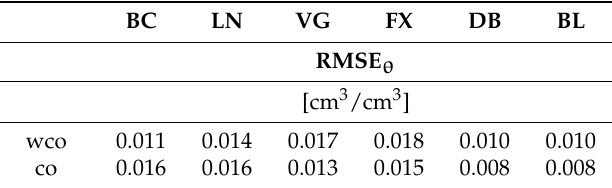
Table 13. Root mean square error of the fitted water content (RMSE θ ) of the boulder marl without compost (wco) and with compost (co): BC model [18], VG model [9], FX model [19], LN model [20], DB model [21], and BL model [22].